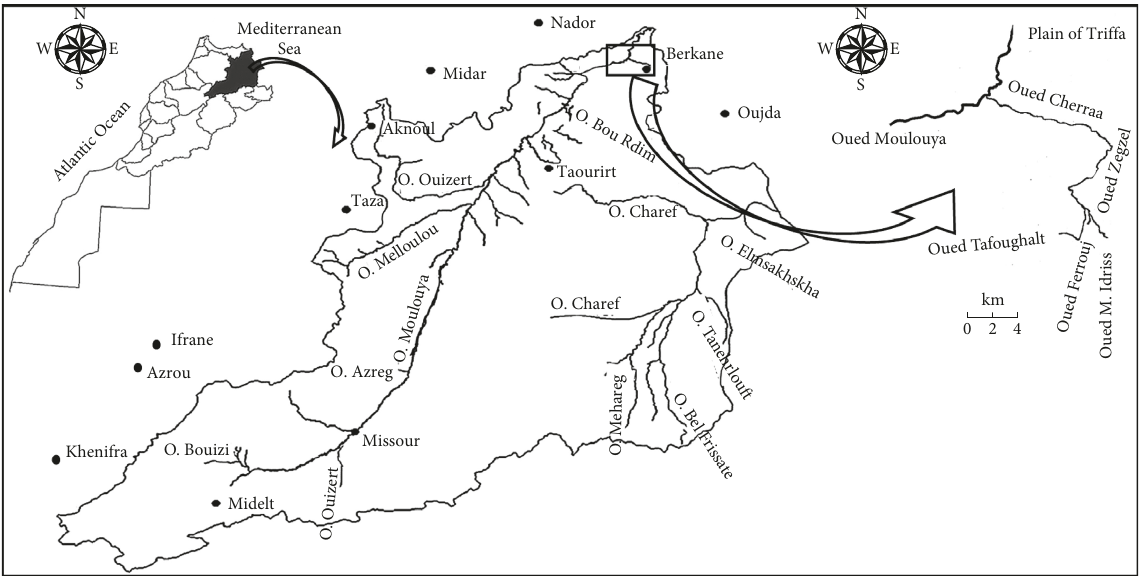
Figure 1: Localization of the study area, Oued Zegzel, Morocco.